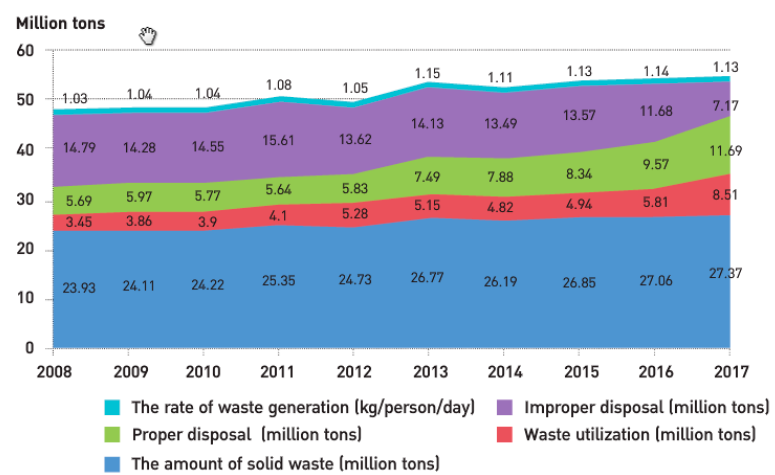
Figure 2. The municipal solid waste statistics in Thailand from 2008 to 2017 [13].